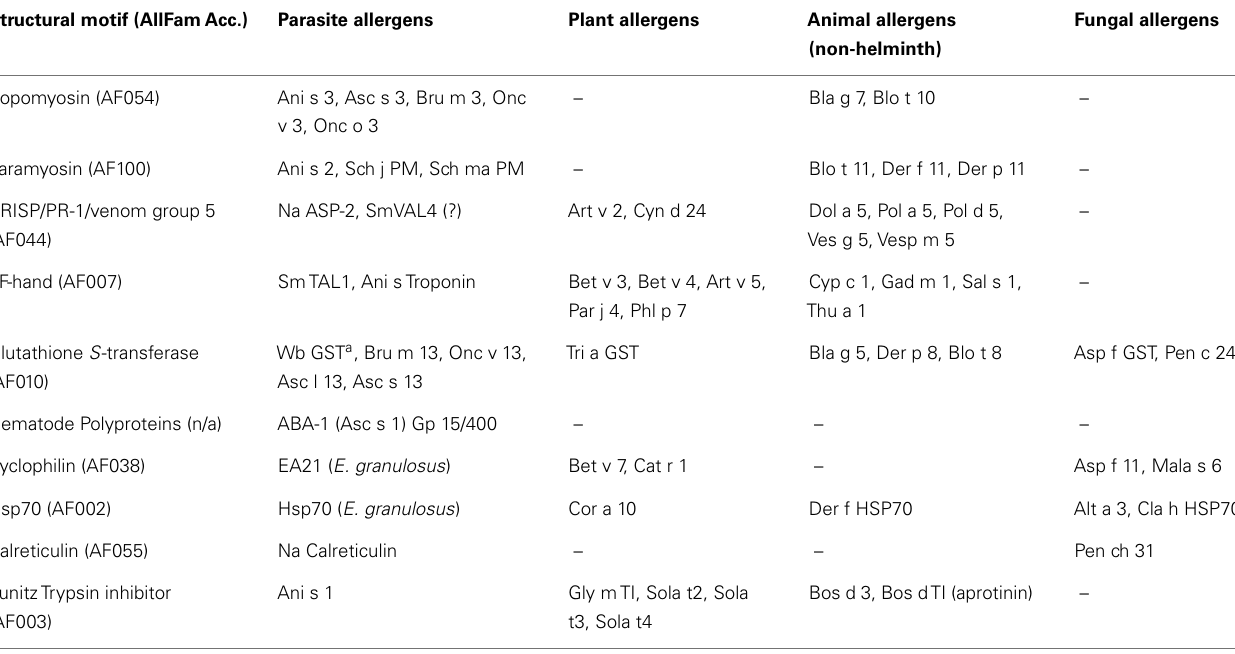
Table 2 | Examples of known allergens, compiled fromAllFam (43) and published literature, illustrating that nearly all families of allergens in animals, plants, or fungi have corresponding allergens in helminths.